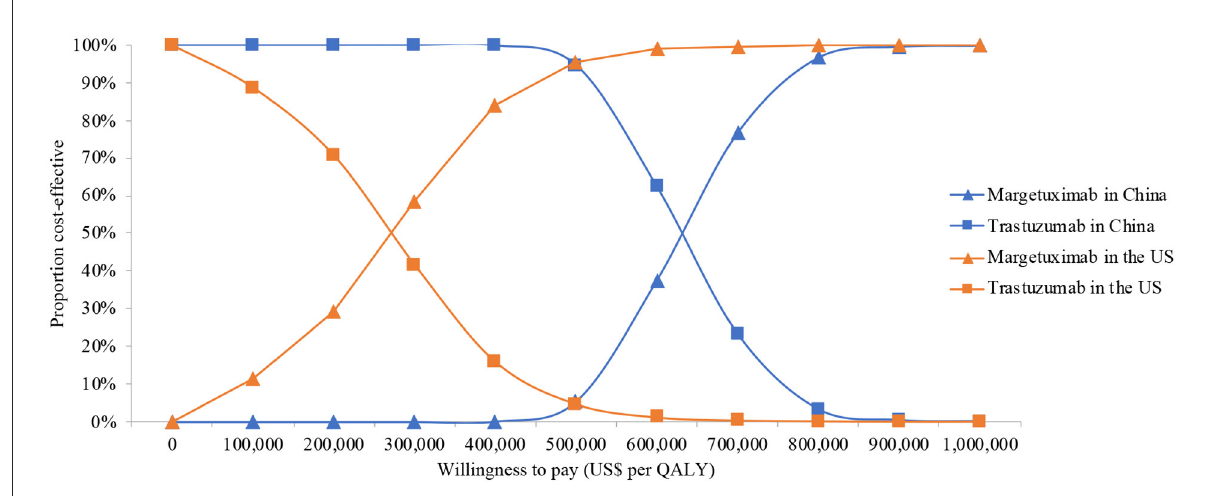
FIGURE3 Cost-effectiveness acceptability curve for the base case analysis from the Chinese and the US perspective. QALYs, quality-adjusted